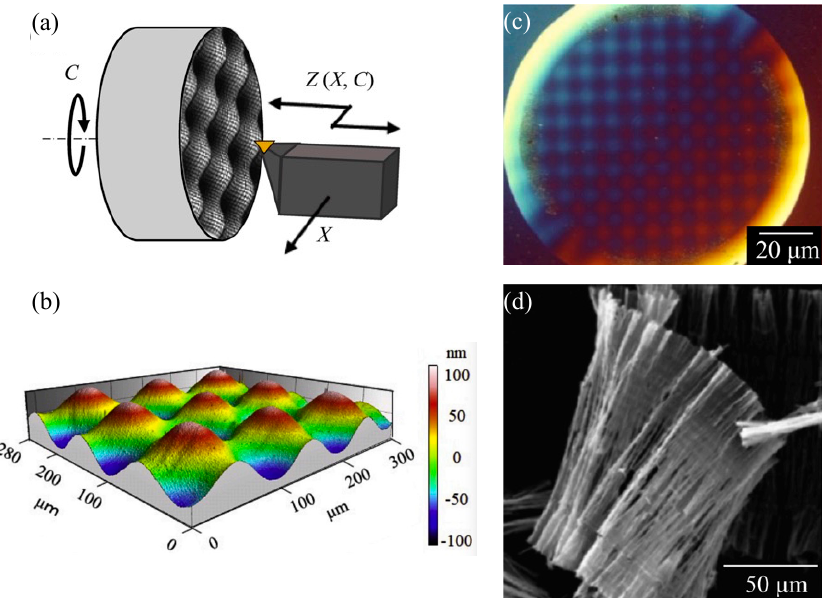
Figure 21. ( a ) STS tuning of the freeform surface. ( b ) 3D image of machined nanometer scaled sine wave grid on single − crystal silicon. ( c ) Microscope image of the machined 2D sine wave grid on single − crystal silicon. ( d ) SEM image of ductile − cut chips, reprinted with permission from Ref. [148] 2021, Elsevier.